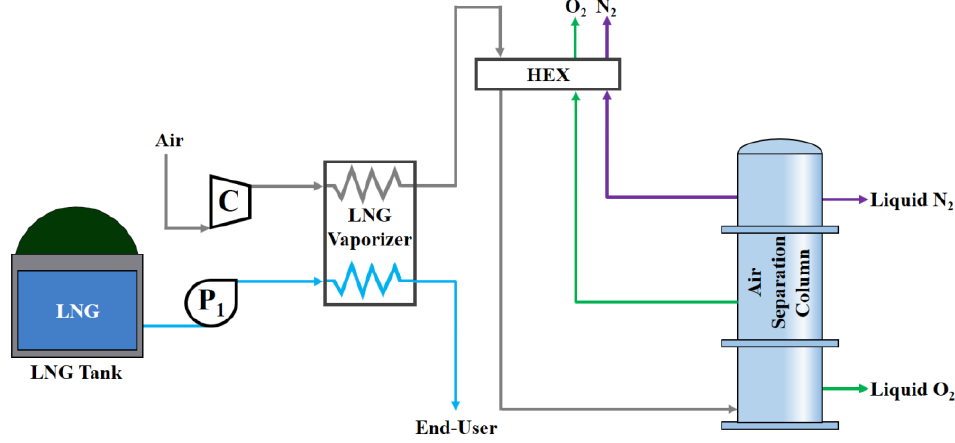
Figure 3. Schematic illustration of single column cryogenic air separation process using LNG cold energy.